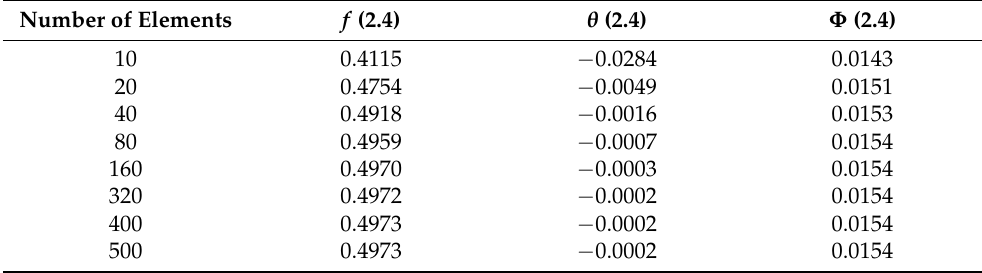
Table 1. Convergence of results exist at M = 3.2, N ∗ = 0.5, ε = 0.2, λ = β t = β c = 0.1, δ =